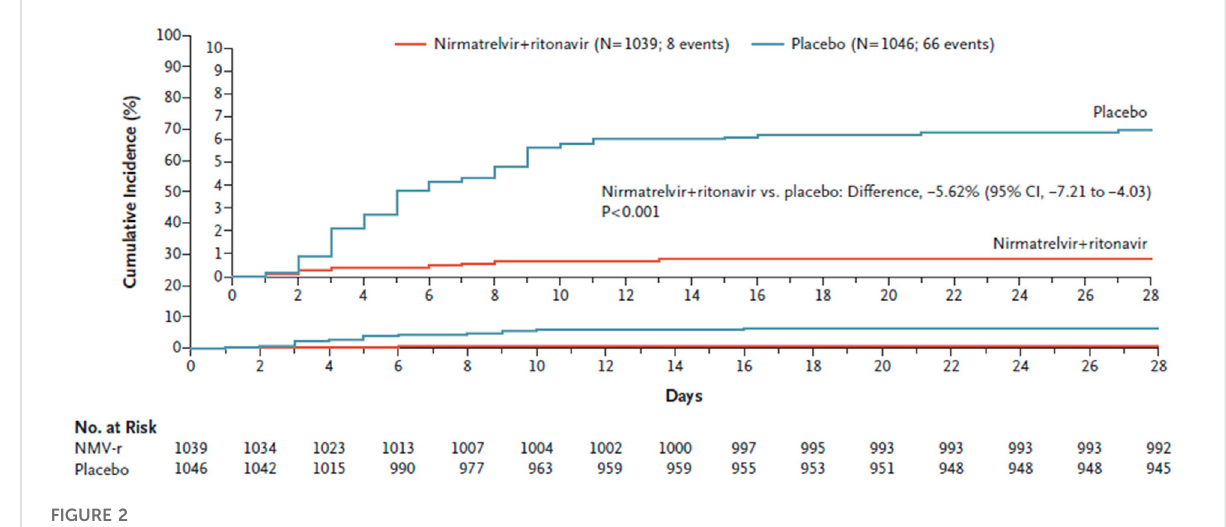
FIGURE 2 Cumulativepercentageofpatients withCOVID-19-relatedhospitalization ordeathfrom anycausethroughday28among thosetreatedwithin 5 days after symptom onset with nirmatrelvir plus ritonavir (Paxlovid) or placebo. (from Hammond et al.,